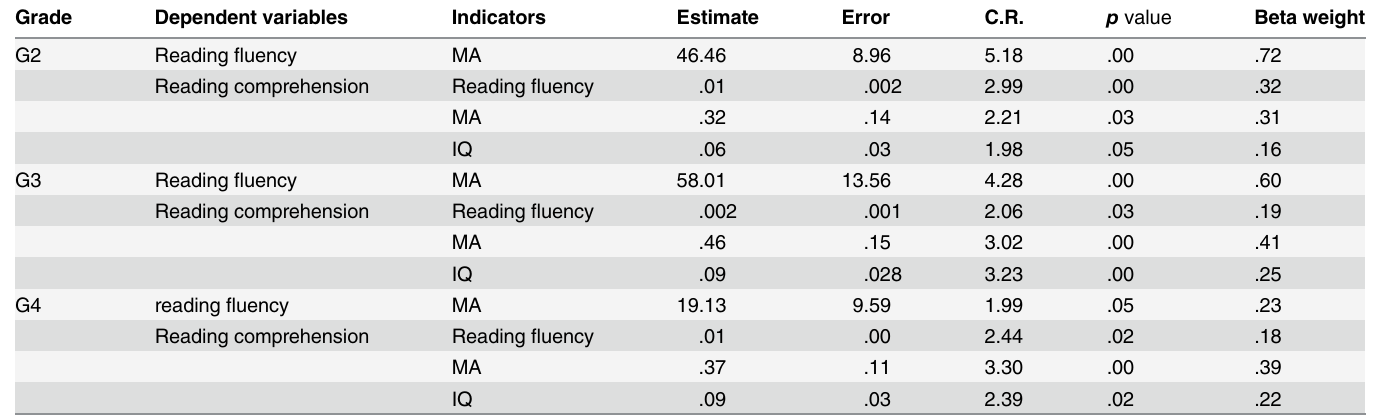
Table 5. The path models for all